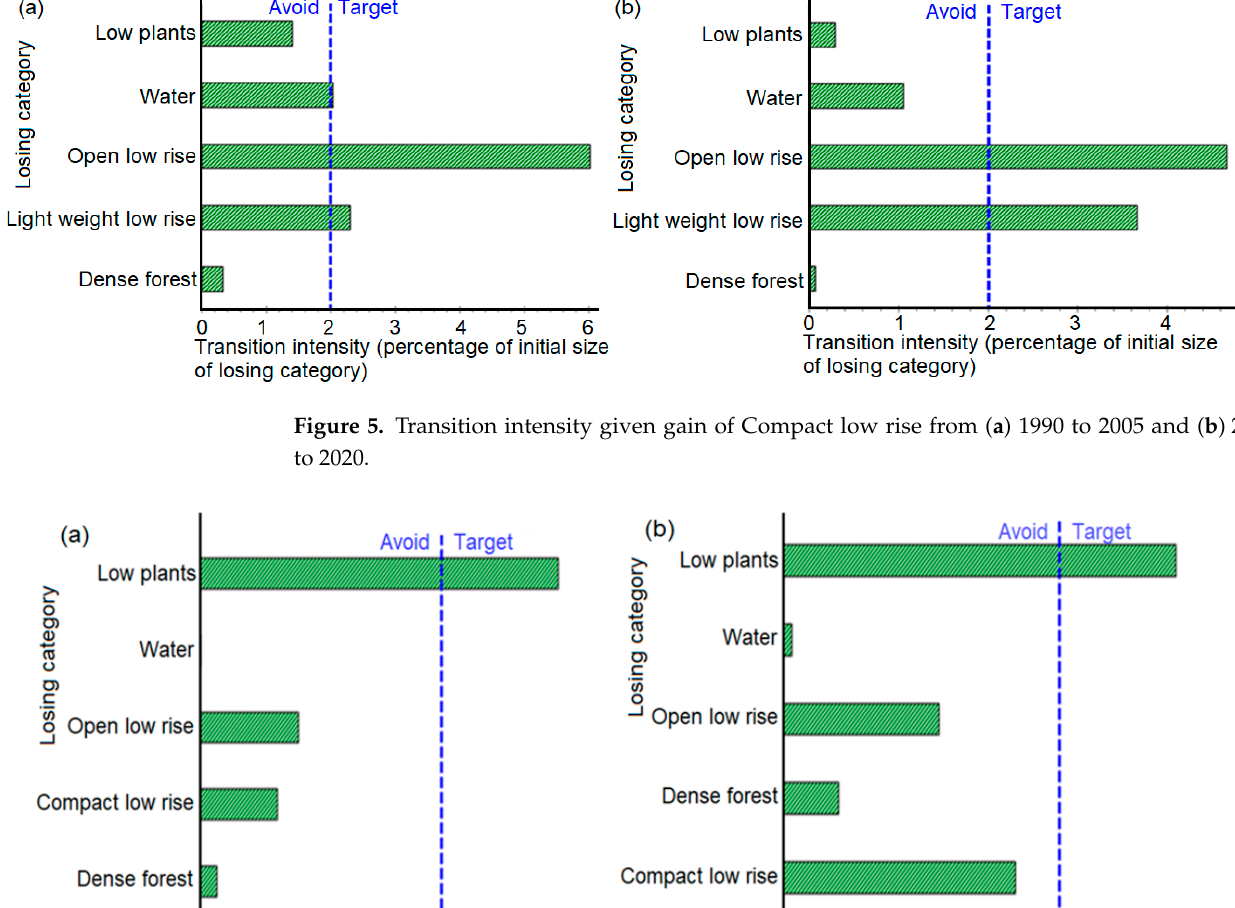
Figure 6. Transition intensity given the gain of Light weight low rise form ( a ) 1990 to 2005 and ( b ) 2005 to 2020.